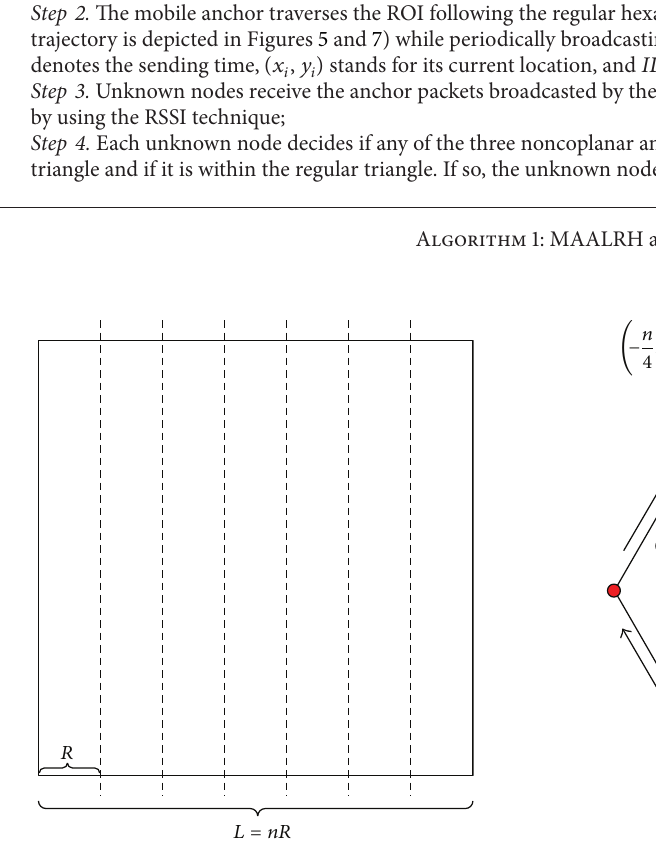
Figure 4: An example of network segmentation.